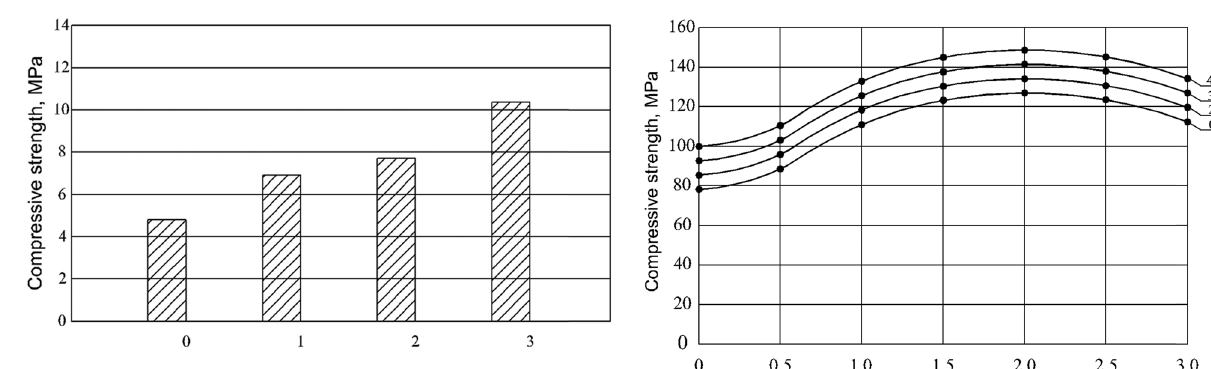
Figure 8: In fl uence of fi bers of fl y ash on the bending strength of cement stone, %.